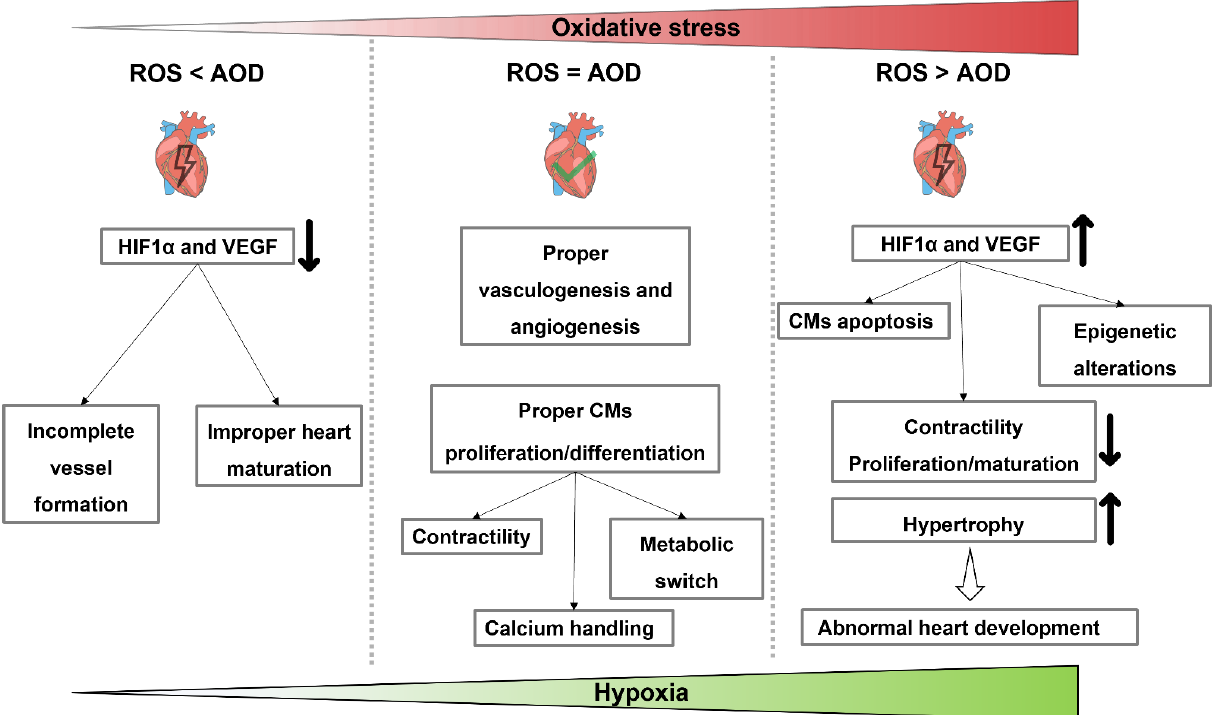
Figure 3. Unbalanced exposure to hypoxia and ROS impairs the antioxidant defences (AOD) and causes alterations to foetal CMs. The affected regulation of cardiac-specific genes, epigenetic modifications and the aberrant cardiac remodelling can lead to CVD in the newborn. AOD: antioxidant defences.